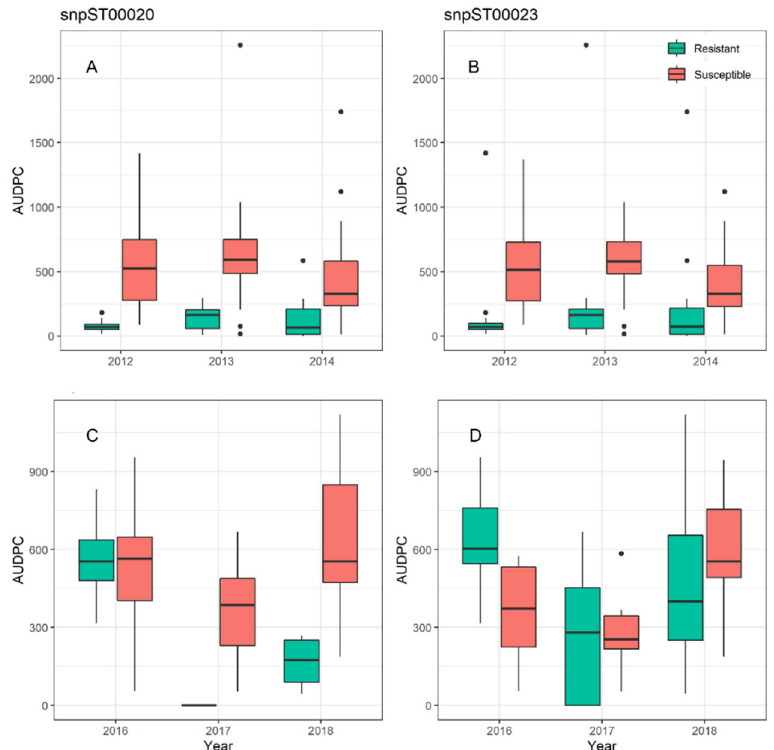
Figure 4. Boxplots of the phenotypic evaluation for late blight resistance of 59 clones of the LBHT ( A , B ), 43 clones, and the LBHT × LTVR ( C , D ), 16 clones, breeding populations, separated according to snpST0020 and snpST0023 genotypes. The phenotypic data were recorded from the field and screenhouse experiments for the LBHT and LBHT × LTVR, respectively (see Materials and Methods).